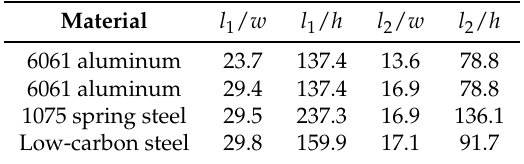
Table 2. Width-to-length and thickness-to-length ratios for the two active lengths used in the experiments ( l 1 = 0.75 m and l 2 = 0.43 m).